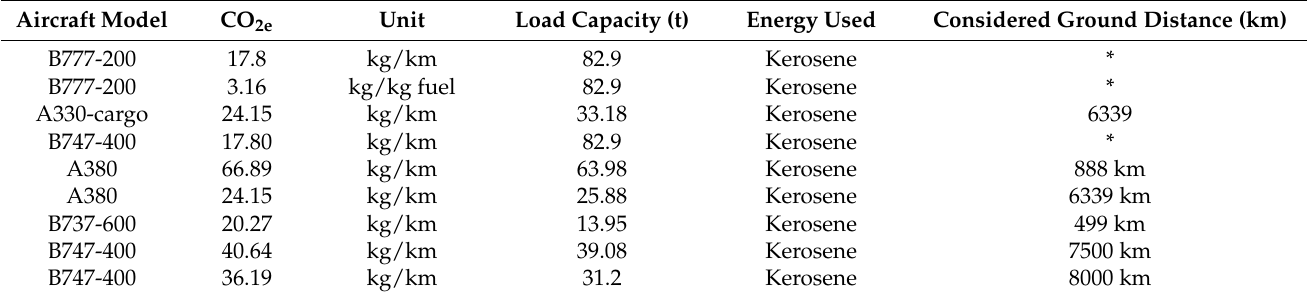
Table 8. Air transport used for long-distance goods shipment and passenger transportation